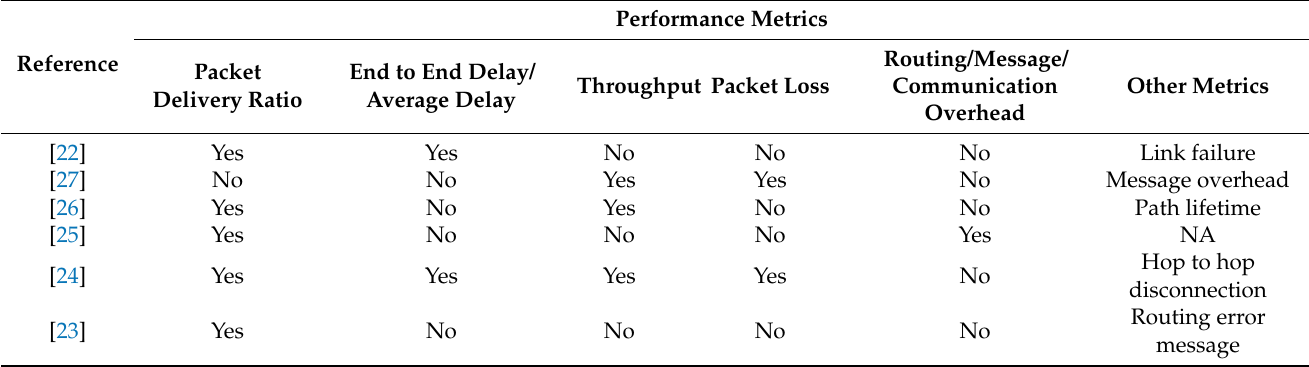
Table 4. Performance metrics of highway scenario-based routing